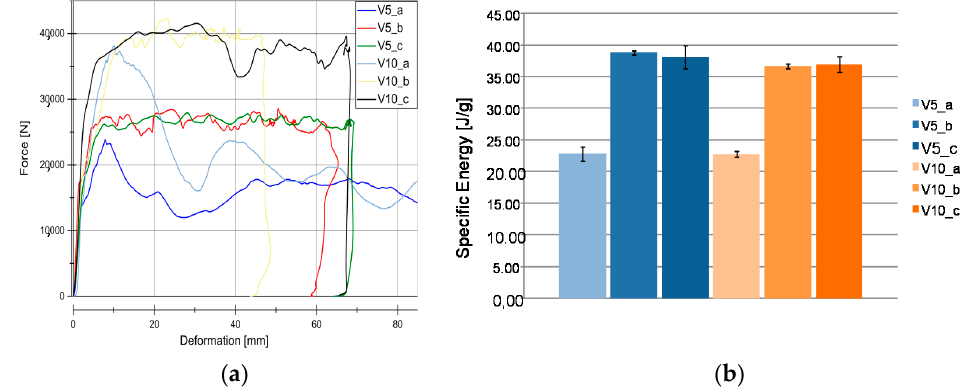
Figure 12. Results for V5 and V10 materials. ( a ) Load-Deformation curve of V5 and V10 material under different velocities rates in crash tests conditions; ( b ) SEA evaluation in V5 and V10 series (Twill/PLA wall thickness evaluation).